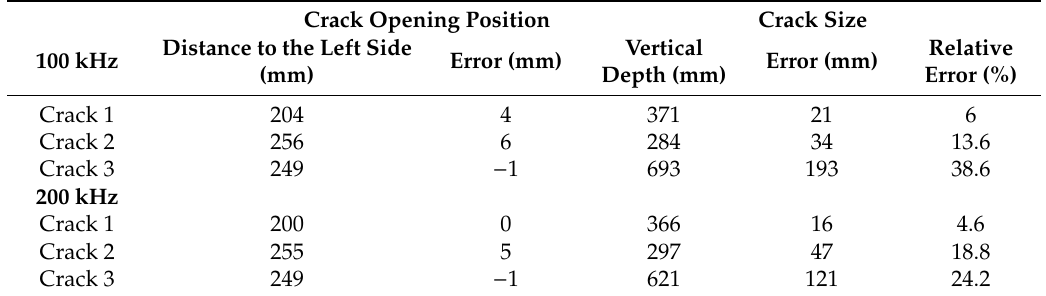
Table 4. Quantitative crack imaging results at the dominating frequency 100 and 200 kHz. Crack Opening Position Crack